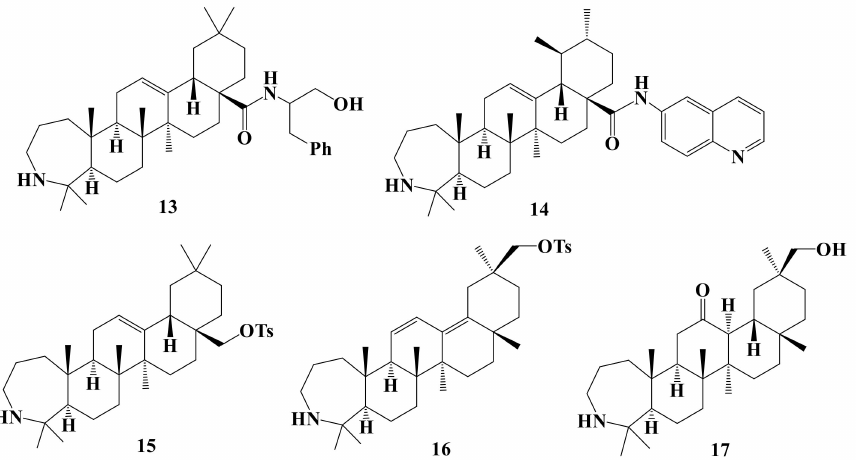
Figure 3. Azepanoerythrodiol, azepanouvaol, and azepano-glycyrrhetol derivatives: Amides 13 and 14 , tosylates 15 and 16 , 12-ketone 17 .